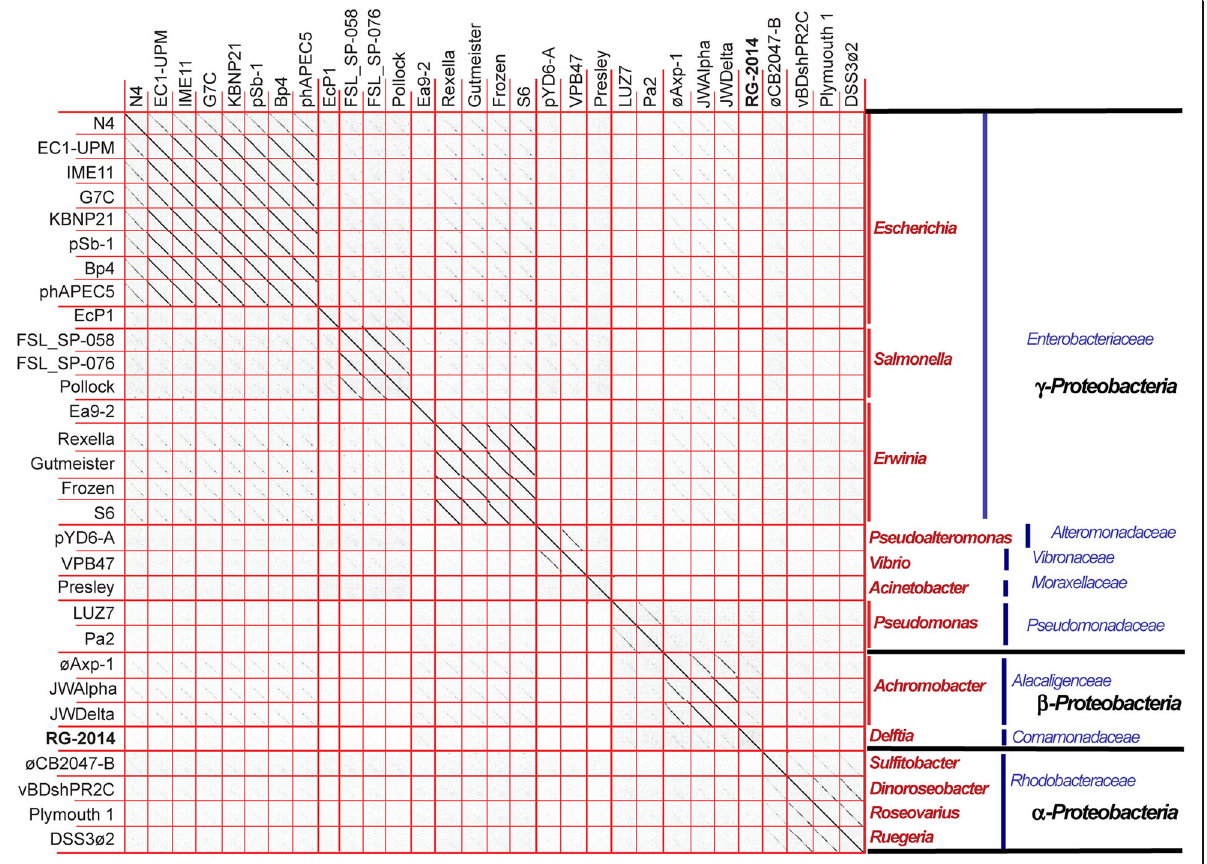
Fig. 4 Dotplot of N4-like phage genomes. Phage genomes were arranged in the same orientation and a dot plot was constructed by Gephard [39] with a word length setting of 11. The phages in the figure include the current extant diversity among the N4-like phages; those that are not included are very similar to one of the phages that is included (their sequences are all in GenBank and can be retrieved by searching with their names). In the plot thin red lines separate the phage genomes, and thick red lines separate the most clearly delineated subtypes. At the right, the genus (red text), family (black text) and class (blue text) of each phage ’ s host bacteria are indicated; vertical very thick red lines on the right indicate phages that infect the same host genus, and very thick blue lines mark host